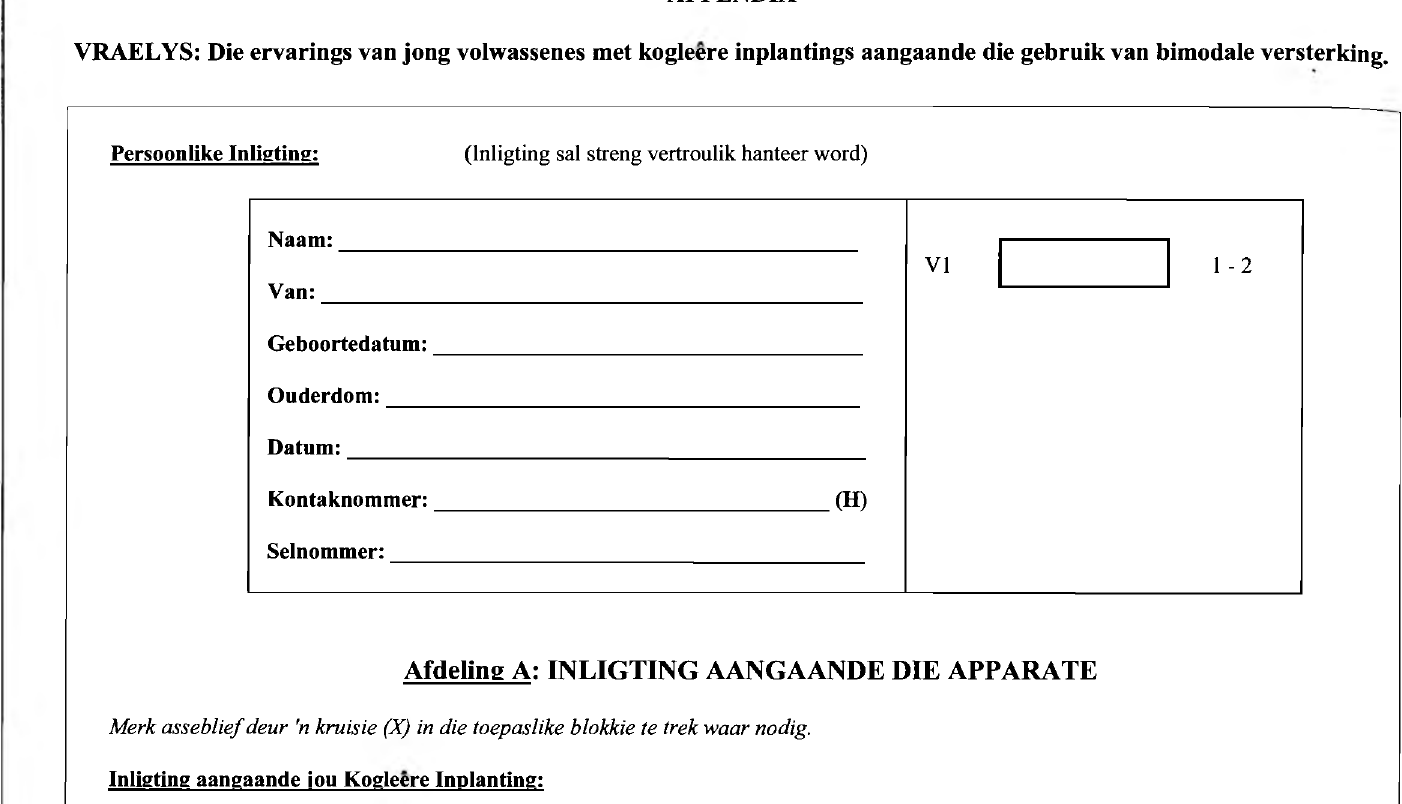
Afdeling A: INLIGTING AANGAANDE DIE